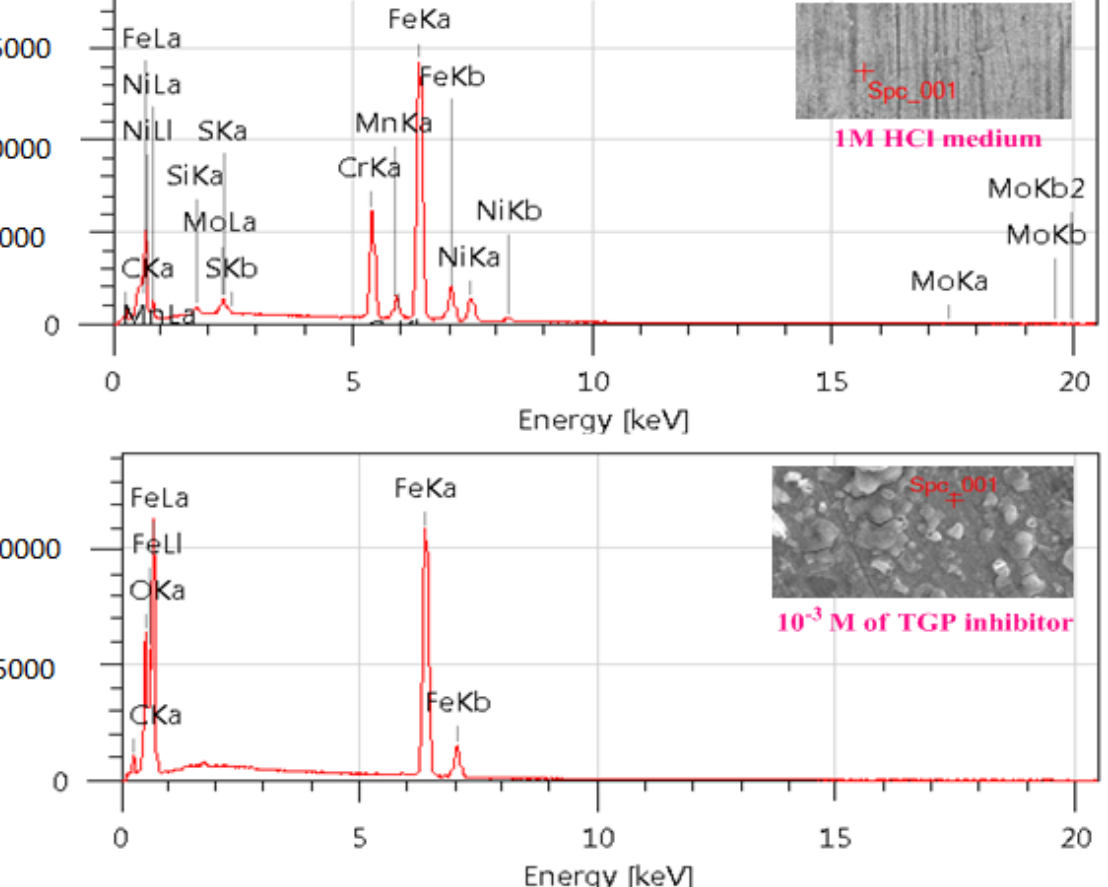
Figure 5. SEM images for MS surface plunged in 1M HCl medium for both unprotected and pro- tected by 10 − 3 M of TGP.